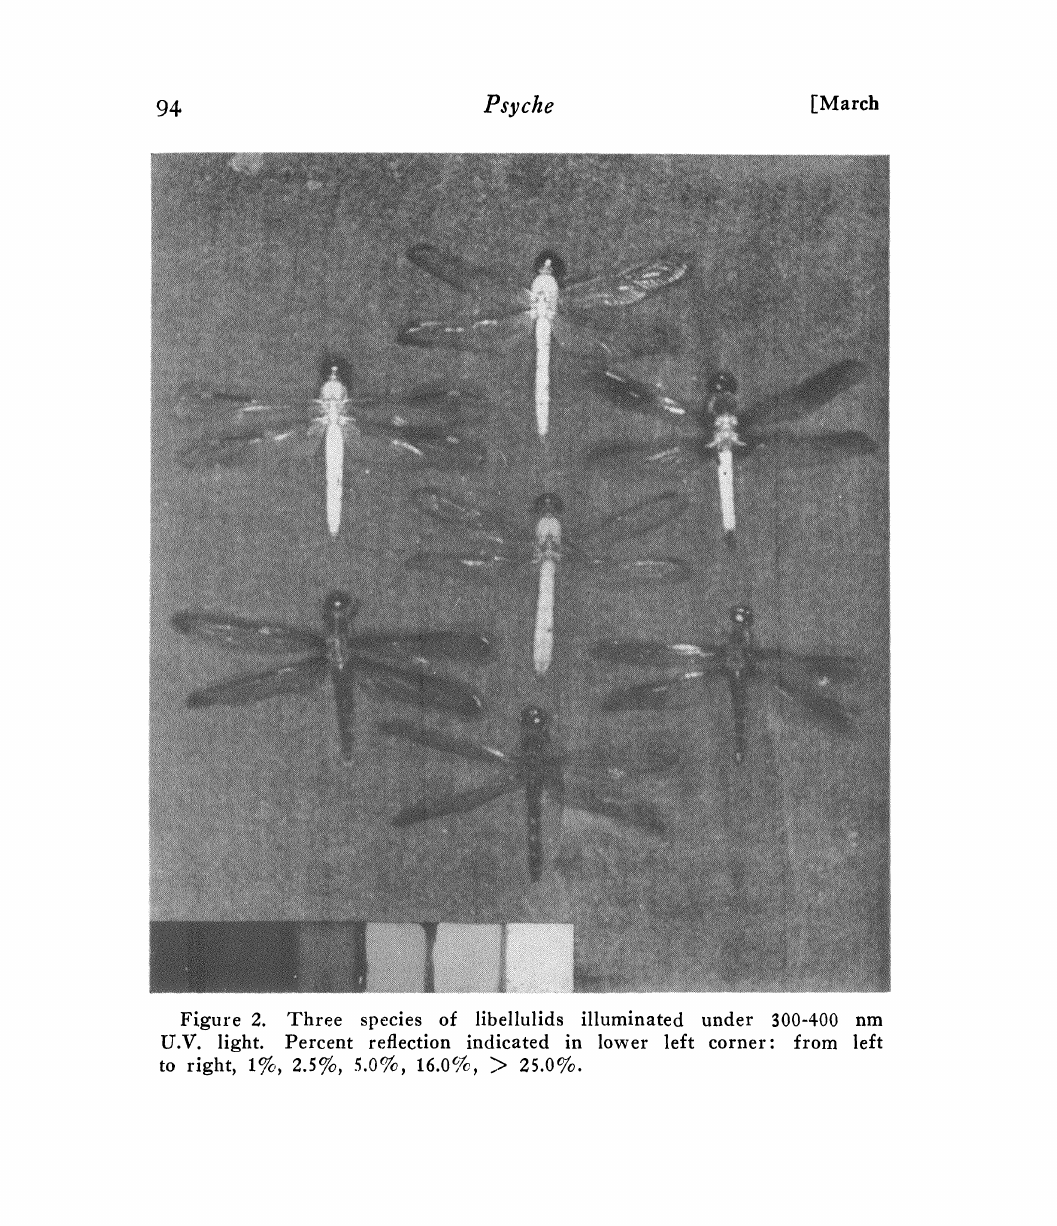
Figure 2. Three species of libellulids illuminated under 300-400 nm U.V. light. Percent reflection indicated in lower left corner" from left > to right, 1%, 2.5%, 5.0%, 16.0%,